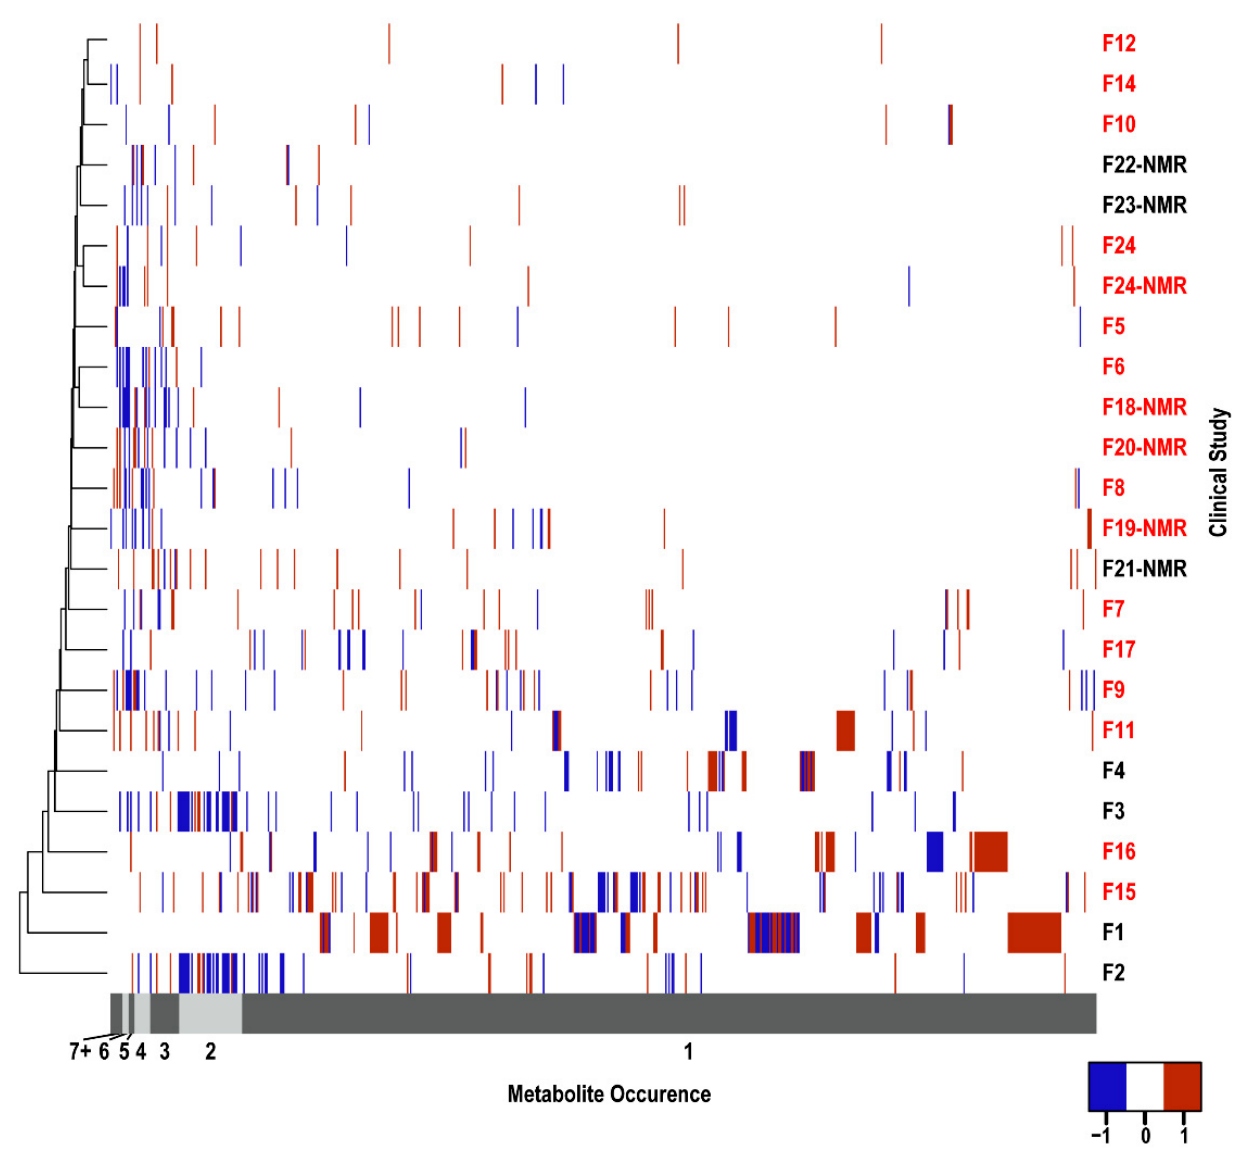
Figure 1. Heatmap of Metabolite Occurrence. A heatmap depicting the distribution of the 655 metabolites identified by the 24 PDAC papers. A hierarchical cluster of the clinical studies was performed where the row numbers correspond to the papers listed in Table 1. The numbers colored red corresponds to studies that used either plasma or serum samples. The NMR label identifies studies that used NMR whereas studies that used mass spectrometry are unlabeled. Metabolite occurrence order corresponds to the groupings in Figure 2A. The exact list and order of the metabolite names can be found in Supplemental Table S1A. For all metabolites with only a single occurrence, the metabolites are ordered alphabetically. Since most studies did not report a quantitative fold change, only a qualitative increase (red, +1) or decrease (blue, − 1) in the metabolite relative to a control is indicated. Metabolites not identified in a study were assigned zero and are